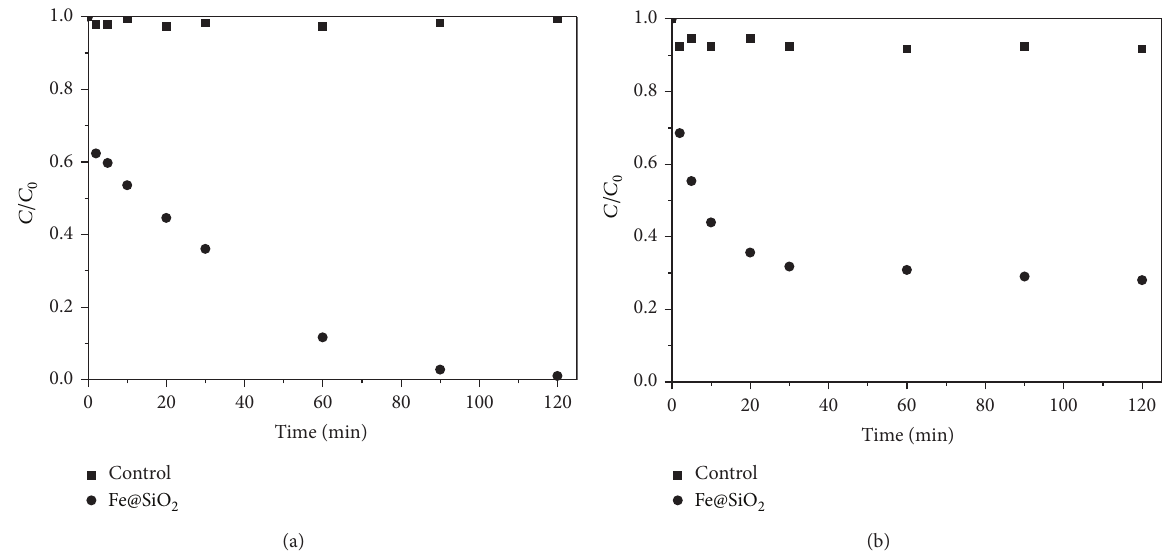
Figure 2: Removal of Cr(VI) (a) and Cd(II) (b) individually using Fe@SiO 2 . Initial Cr(VI) and Cd(II) concentration: 70 mg ⋅ L −1 , Fe dose: 0.15g ⋅ L −1 , pH: 6.0 ± 0.1 , and temperature: 25 ∘ C.